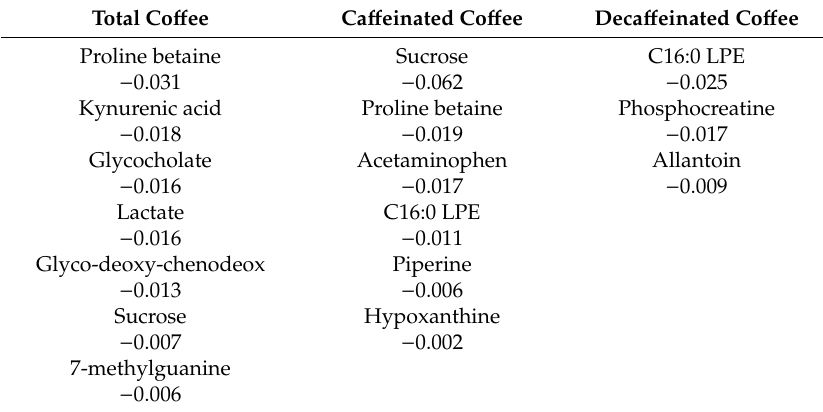
Table 3. Metabolites ranked from the highest to the lowest elastic net negative regression coe ffi cients for co ff ee and its types